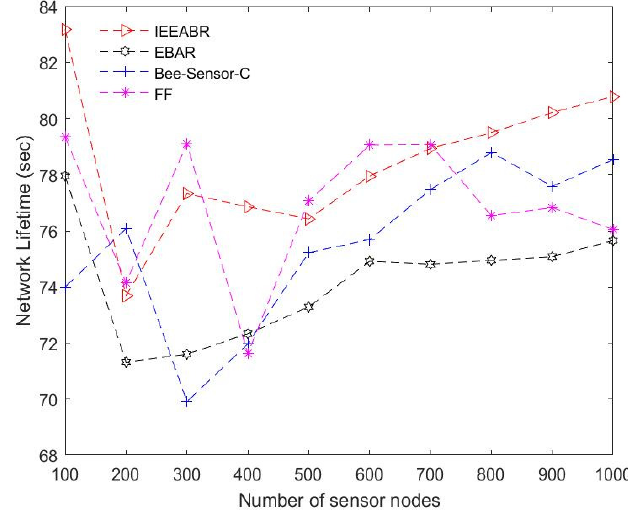
Figure 16. Comparison in terms of network lifetime.